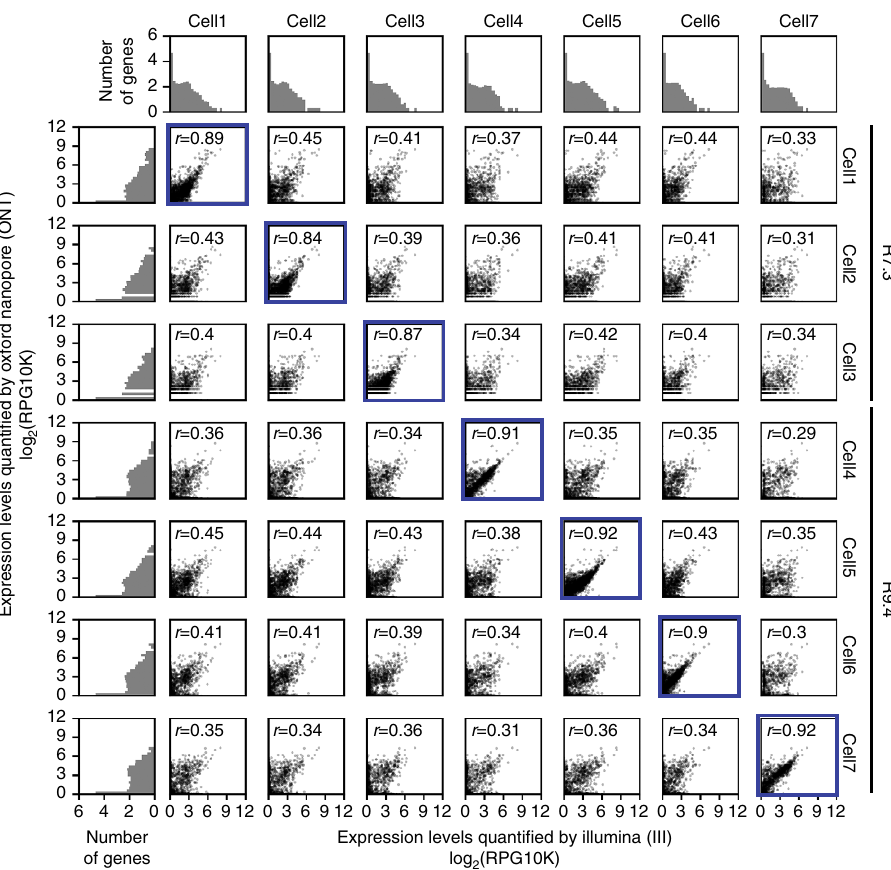
Figure 2 | ONT RNAseq recapitulates Illumina RNAseq gene expression quantification. Scatter plot grid at the centre of the figure shows gene expression levels for each gene as determined by Illumina RNAseq and ONT RNAseq for the indicated cells. Correlations of gene expression levels are given as reads per gene per 10,000 reads (RPG10K) across seven single cells. Pearson r is given for each cell per sequencing method combination with each point representing transcript expression level ( x -axes ¼ Illumina and y -axes ¼ ONT). Same cell comparisons have a blue border. ONT sequencing chemistry is shown on the right. Histograms found on the left and top of the figure represent number of genes found binned by their expression